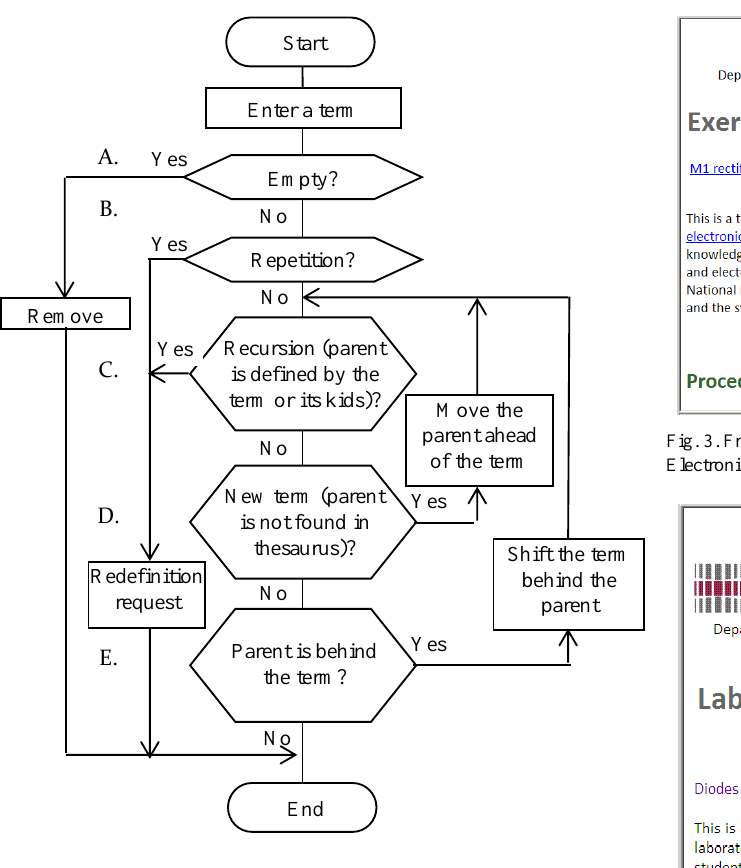
Fig. 2. Thesaurus ranking algorithm.